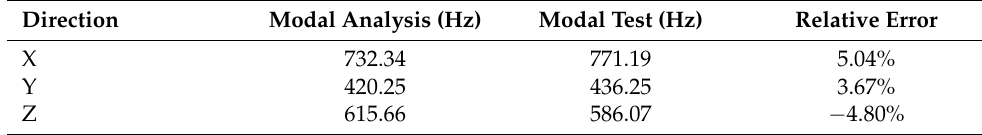
Figure 9. First 4 orders of vibration and frequency: ( a ) First order Y-directional vibration frequency is 420.25 Hz. ( b ) Second order Z-directional vibration frequency is 615.66 Hz. ( c ) Third order local vibration frequency is 618.68 Hz. ( d ) Fourth order X-directional vibration frequency is 732.34 Hz. Table 6. Modal data.